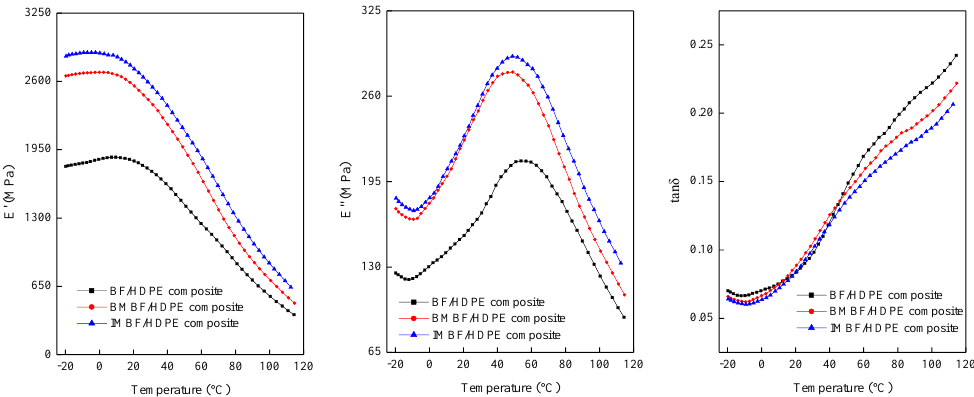
Figure 3. Single-frequency dynamic thermo-mechanical properties of composites (1 Hz).